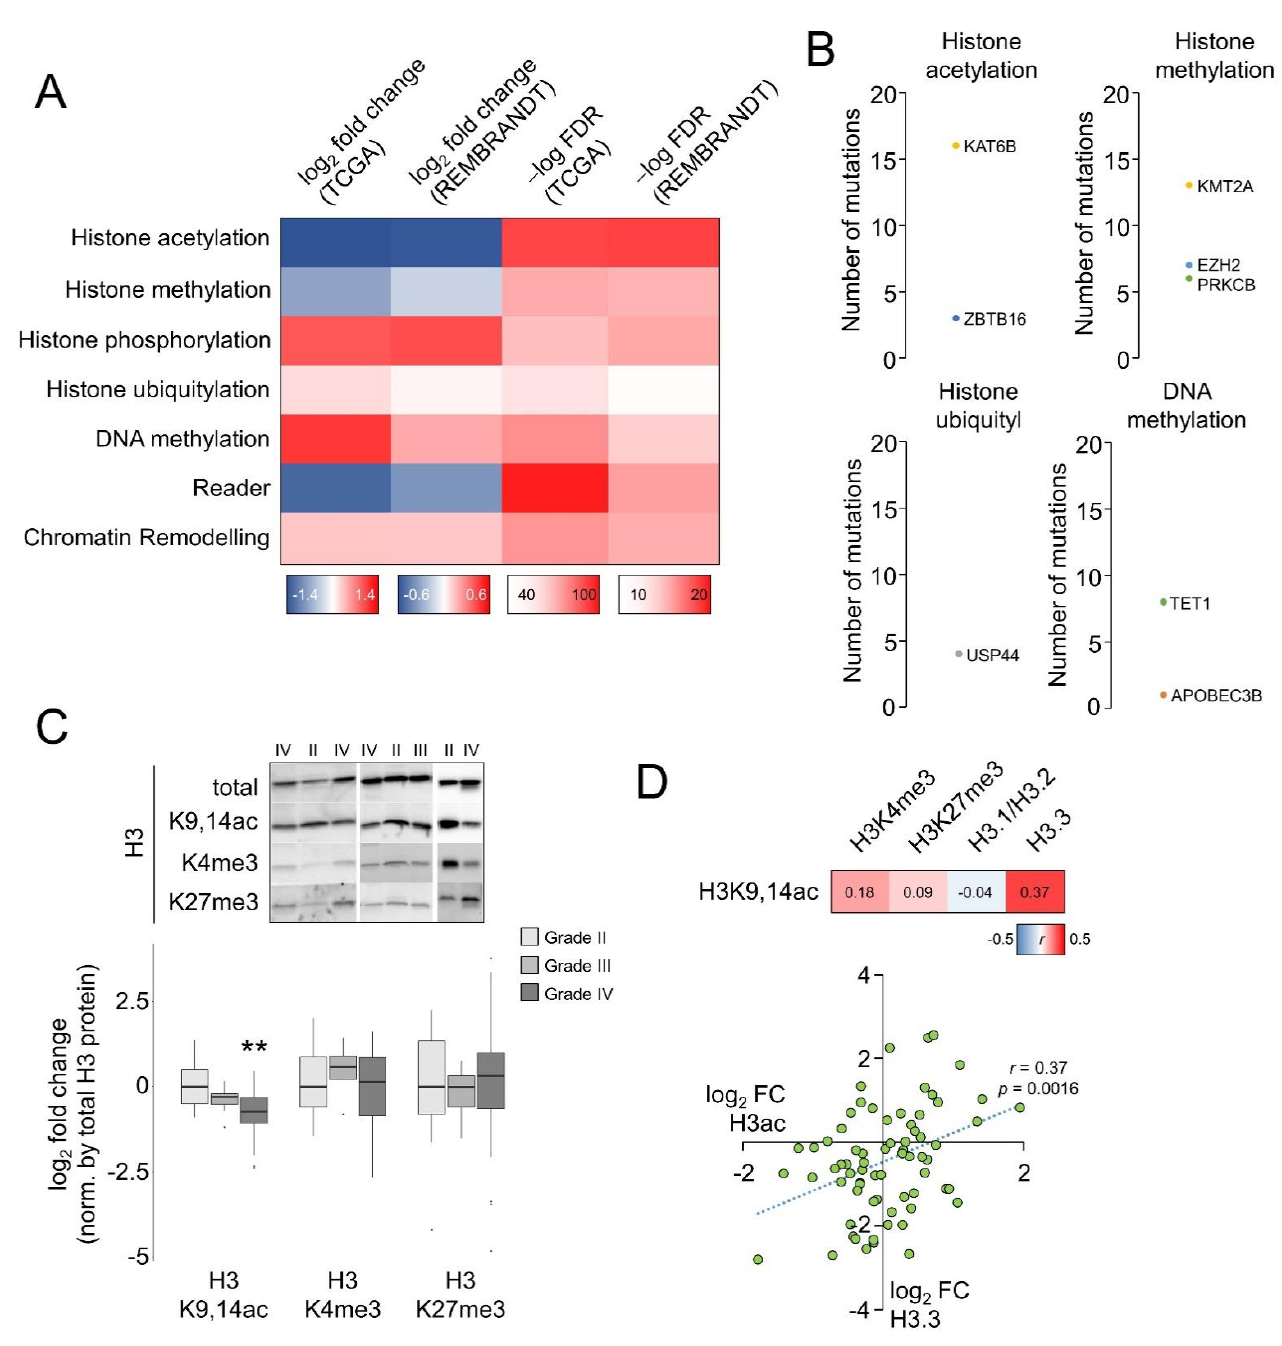
Figure 1. Histone H3 deacetylation in glioblastomas: ( A ) Genes with differential expression between the datasets of “GBM” and “LGG” projects of TCGA that were also confirmed in the REMBRANDT cohort. Individual values of fold change and adjusted p -values are shown in Figure S1. FDR, false discovery rate. ( B ) For the number of somatic mutations, we only consider nonsynonymous substitutions in protein coding regions in the differentially expressed genes of ( A ). ( C ) Upper panel, representative Western blots for total and covalently modified histones in tumor resections where each lane represents a patient’s sample; the number denotes the histological grade. Lower panel, quantification of the blots after normalization by the total H3 signal. n = 13 for grade II, n = 7 for grade III, n = 57 for grade IV (GB). **, p -value < 0.005, Mann–Whitney U test related to grade II. Raw blots are shown in Figure S2 with the location of the image crops. ( D ) Pearson correlation coefficients ( r ) for H3K9,14ac levels and other histone modifications (this study) and histone H3 variants [23]. The plot shows the correlation between H3K9,14ac and H3.3, the only one to be